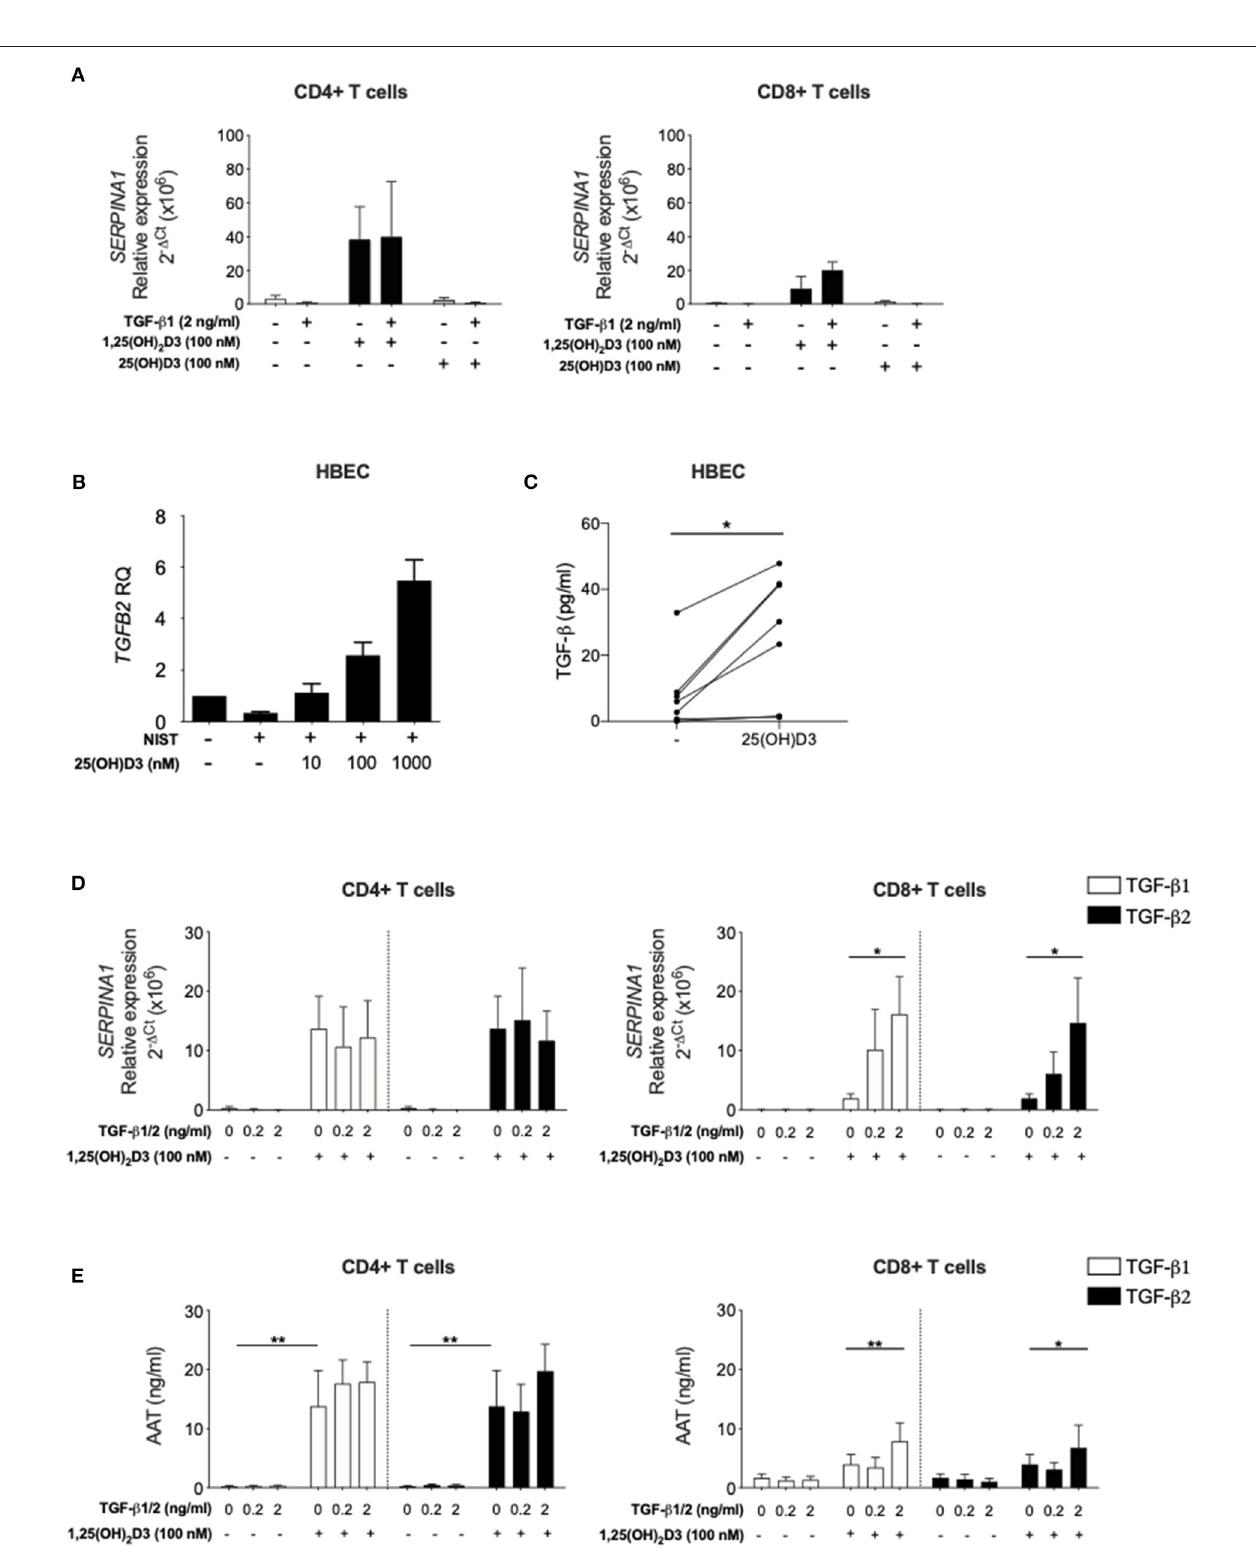
FIGURE 4 | Inactive vitamin D does not induce SERPINA1 expression in T cells, but does induce production of bioactive TGF- β in HBECs. Both TGF- β isoforms upregulate 1,25(OH) 2 D3-mediated SERPINA1 /AAT induction in CD8 + T cells. (A) CD4 + and CD8 + T cells were isolated from peripheral blood of healthy donors